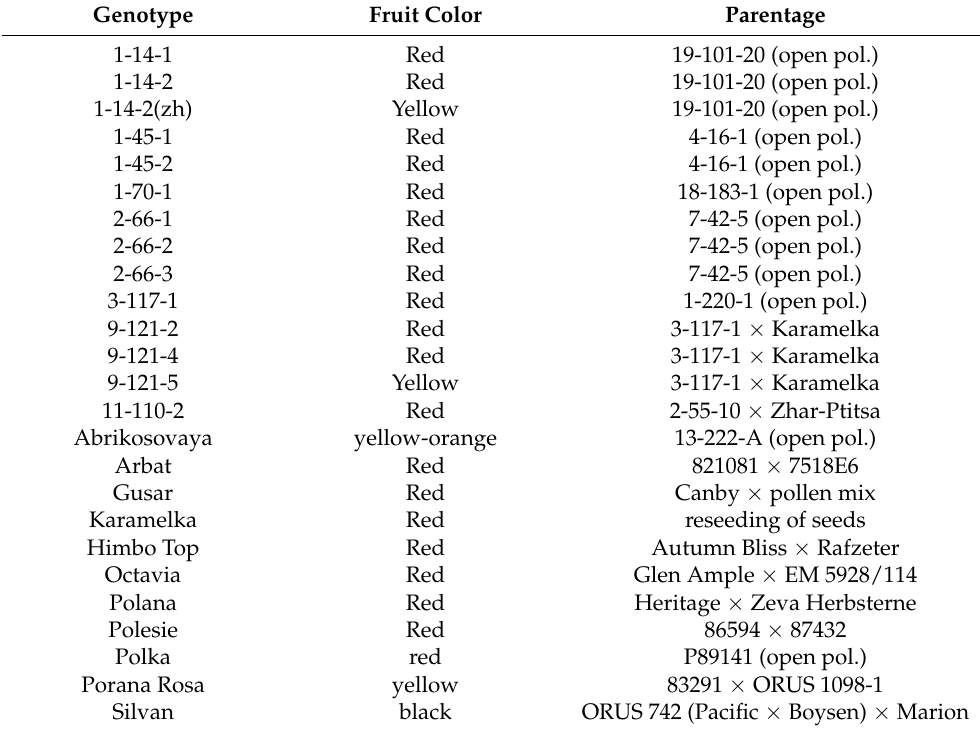
Table 1. Parentage of tested raspberry cultivars and breeding